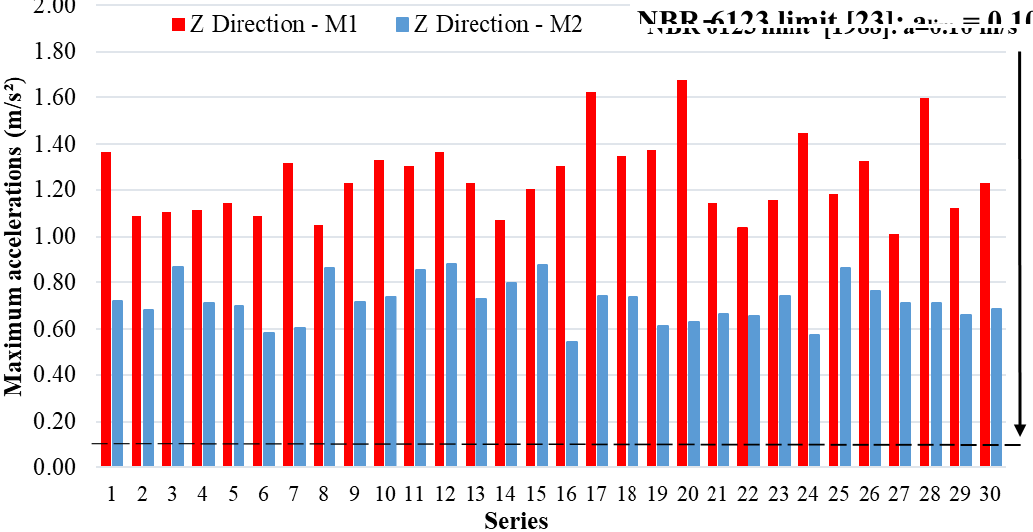
Fig. 11. Maximum accelerations (peak accelerations) in Z direction (H = 45 m): M1 and M2. Table 4 Mean maximum values (30 nondeterministic wind series): displacements and accelerations. Wind Loads Direction